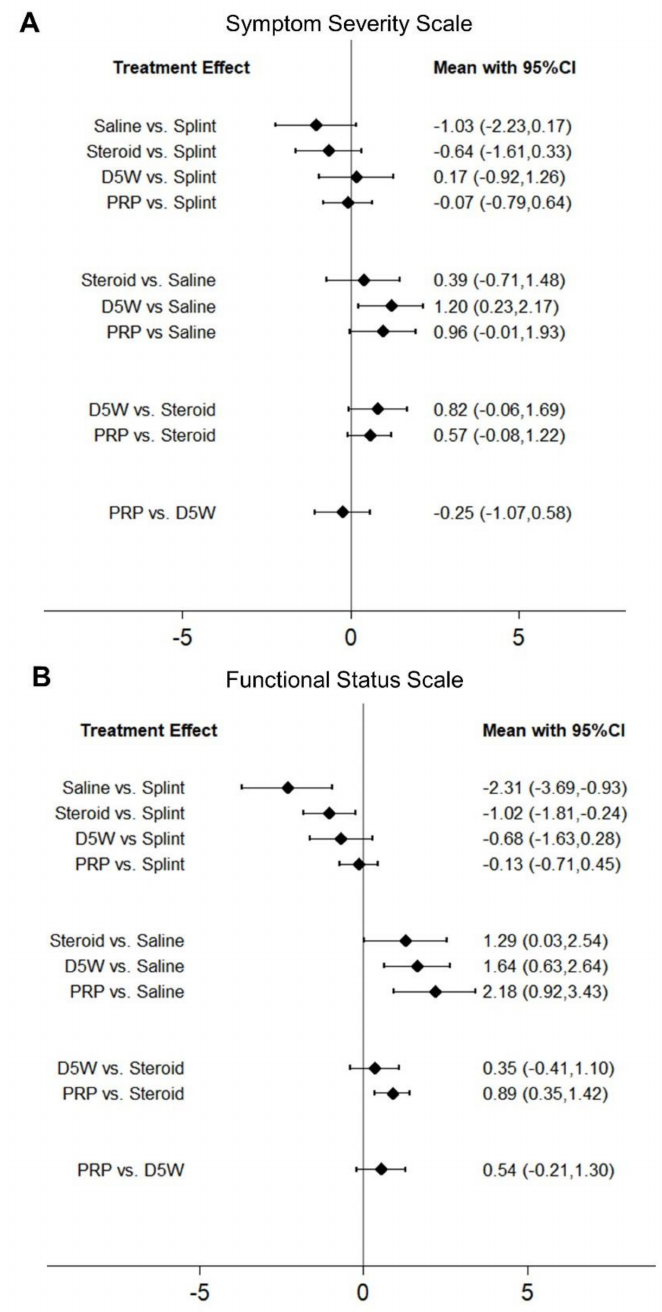
Figure 3. Forest plot of the network comparison of the standardized mean di ff erence between di ff erent subgroups in terms of the ( A ) symptom severity scale and ( B ) functional status scale of the Boston Carpal Tunnel Questionnaire. PRP, platelet-rich plasma; D5W, 5%